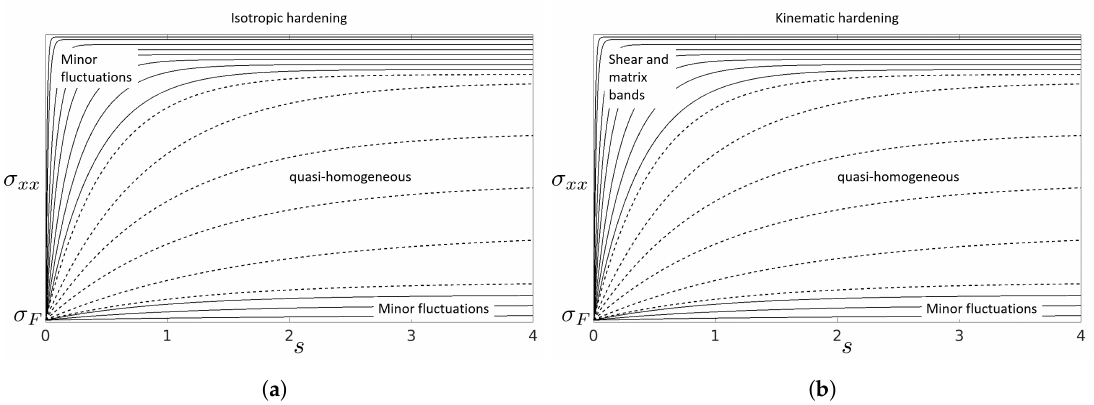
Figure 11. Generalized diagram with uniaxial flow curves as functions of the effective plastic strain depicting the regions where localized deformation occurs for ( a ) isotropic and ( b ) kinematic hardening. Material parameters corresponding to flow curves in the marked regions lead to the indicated solution. Note that, despite the apparent similarity of the uniaxial flow curves, isotropic and kinematic hardening are fundamentally different in the multiaxial